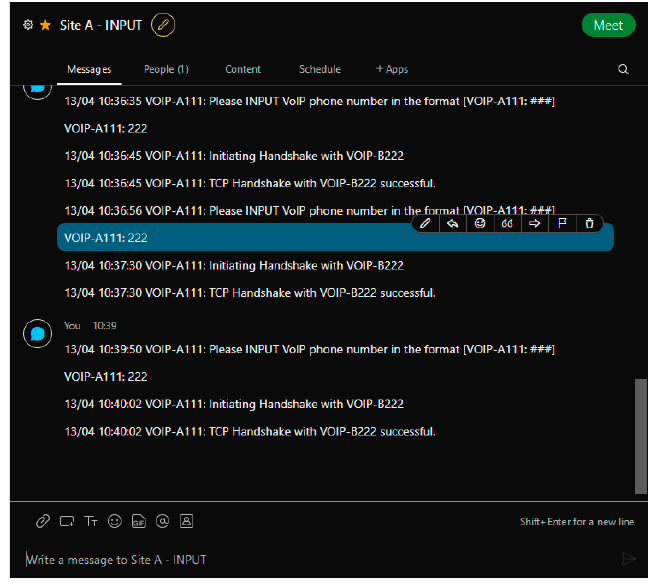
Figure 6. Cisco Webex input room.